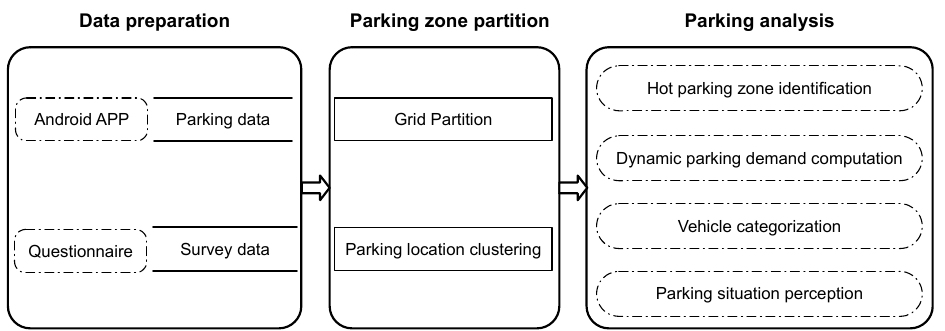
Figure 2. The three sequential stages of the research, including the data preparation stage, the parking zone partition stage and the parking analysis stage.